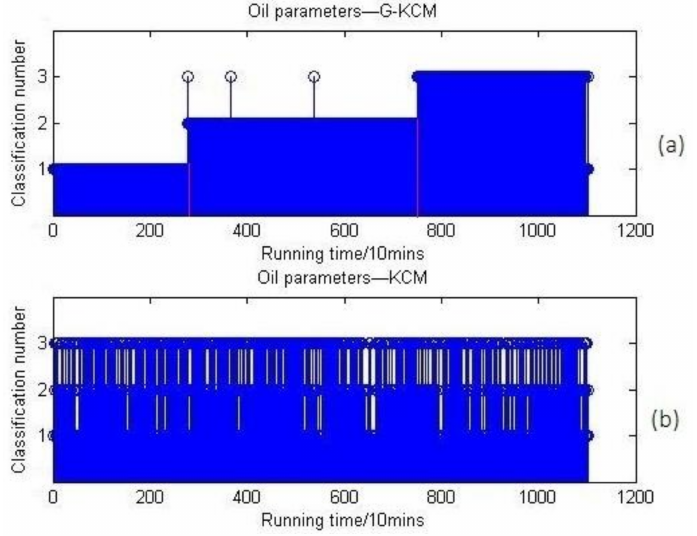
Figure 17. ( a ) Online oil multi-parameters clustering results based on G-KCM; ( b ) online oil multi-parameters clustering results based on KCM.